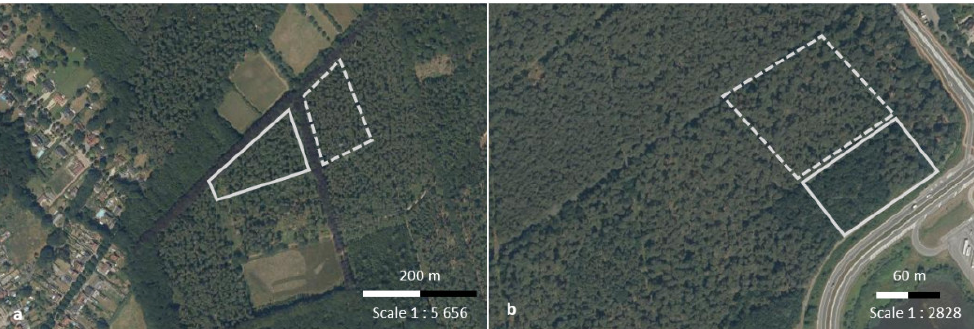
Figure 1. Aerial photos of the study sites. ( a ): De Inslag with the reference pine stand (dashed line) and the thinned pine stand (solid line); ( b ): De Mik with the reference pine stand (dashed line) and oak stand planted after the clear cut (solid line). Screenshot from [35].